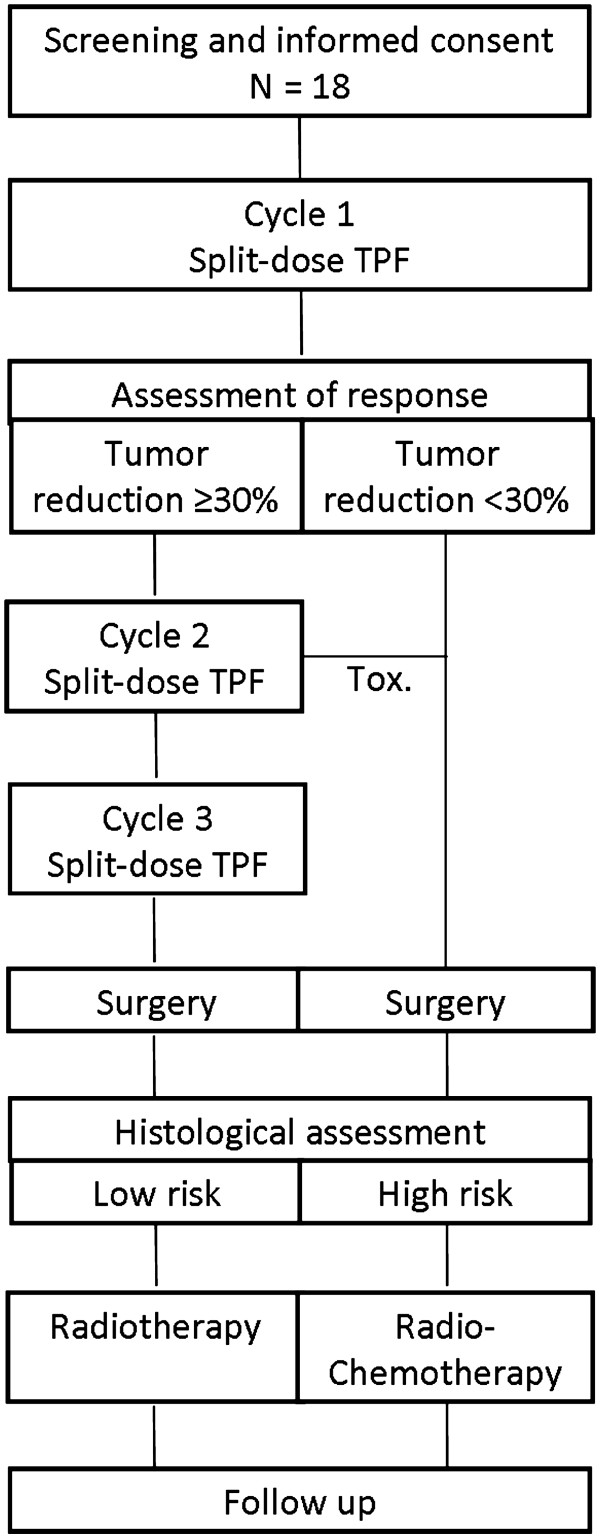
Treatment schedule. TPF, docetaxel+cisplatin+5-fluorouracil; Tox, determination of induction chemotherapy because of toxicity (did not occur).